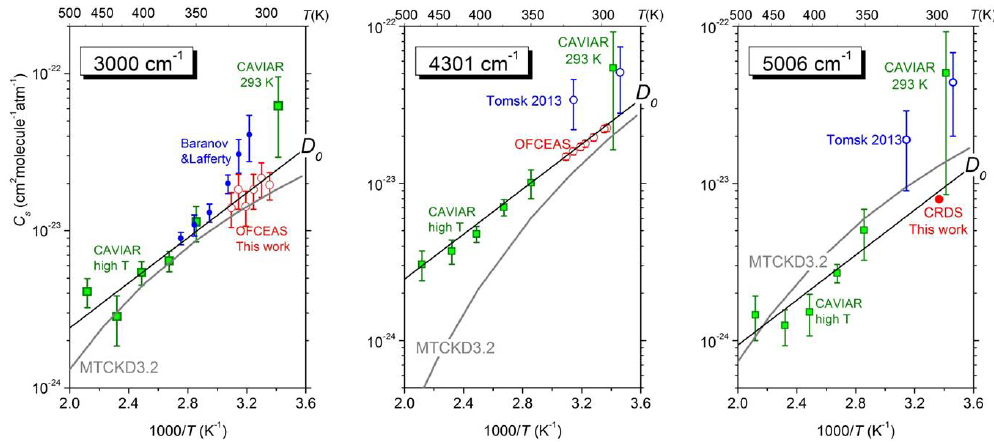
Figure 7. Temperature dependence of the water vapour self-continuum cross-sections near 3000, 4301, and 5006cm − 1 obtained by OFCEAS and CRDS (open and full red circles, respectively), by FTS (green squares: CAVIAR; full blue circles: Baranov and Lafferty, 2011; open blue squares: Tomsk 2013). The MT_CKD3.2 values which are normalised to the number density at 1atm and 296K were multiplied by 296/ T . The D 0 slope corresponds to an exp( D 0 /kT ) function, D 0 ≈ 1100cm − 1 being the dissociation energy of the water dimer